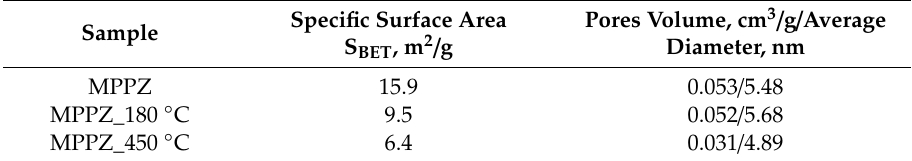
Table 2. Specific surface of the crushed samples for determine hydrolytic stability in accordance with the PCT test.